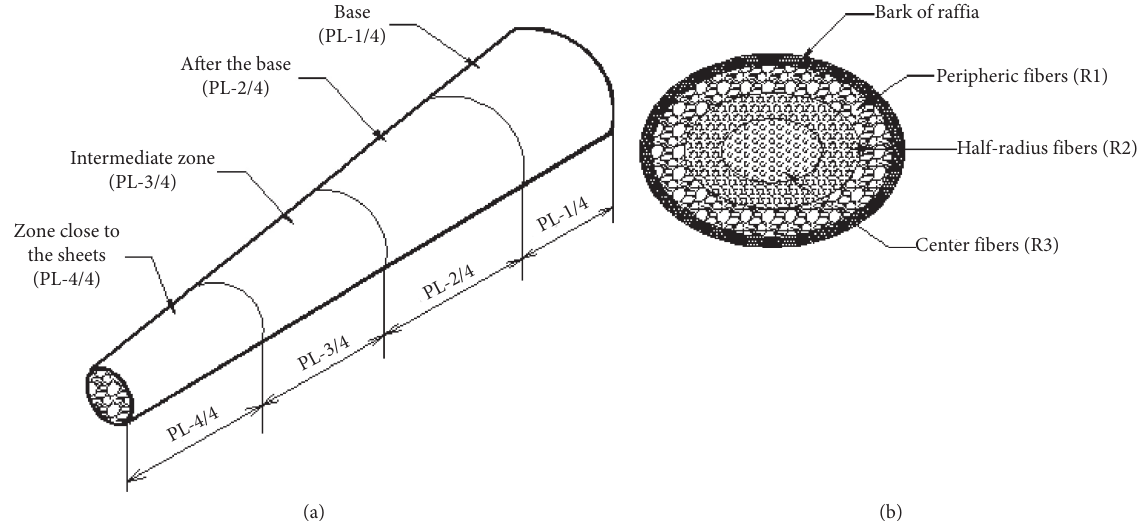
Figure 1: Location of fiber sampling areas along the RV stem: (a) longitudinal position; (b) cross section in a precise longitudinal position